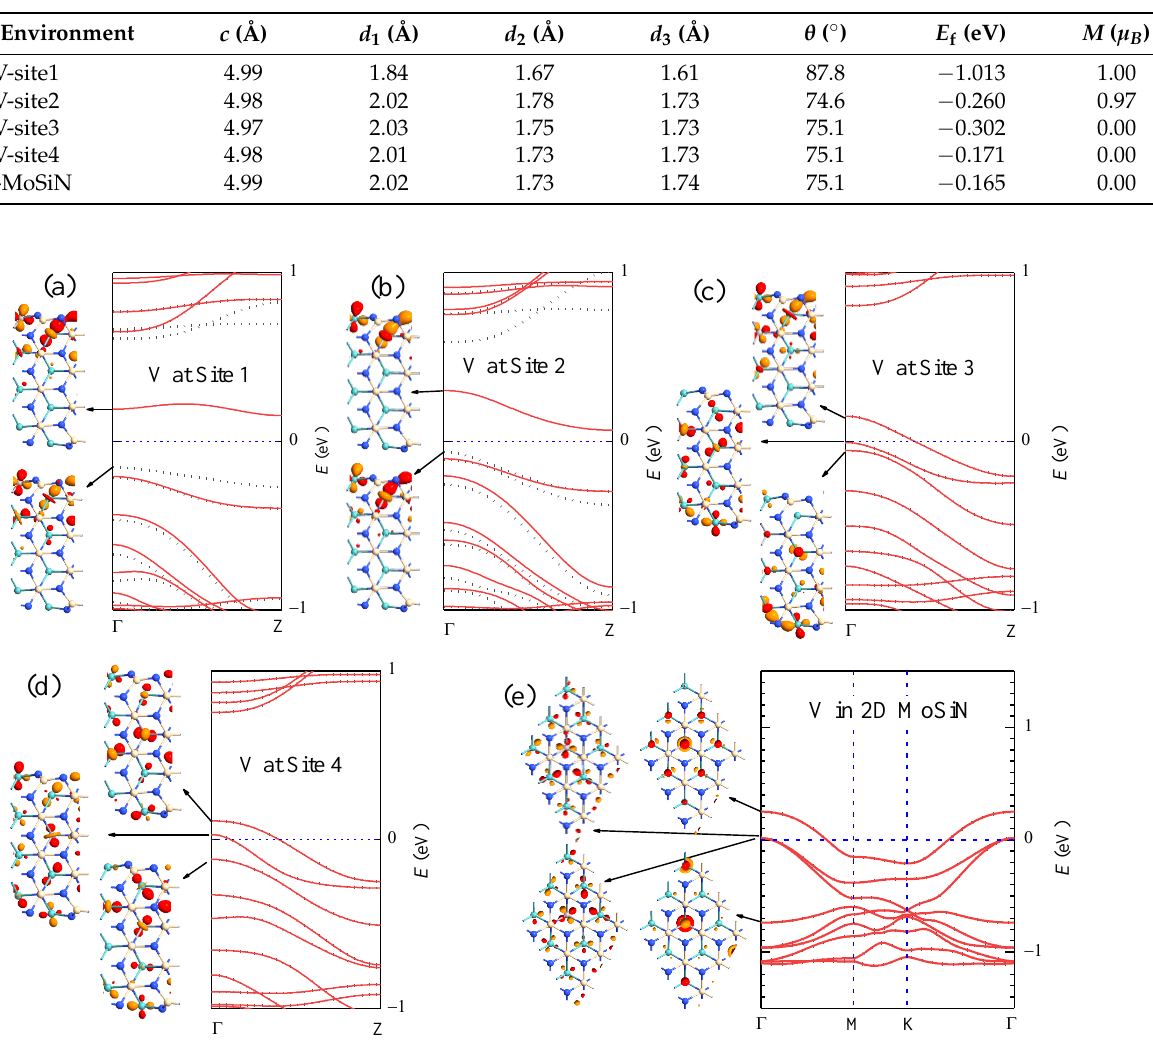
Table 3. The typical structural parameters c ,